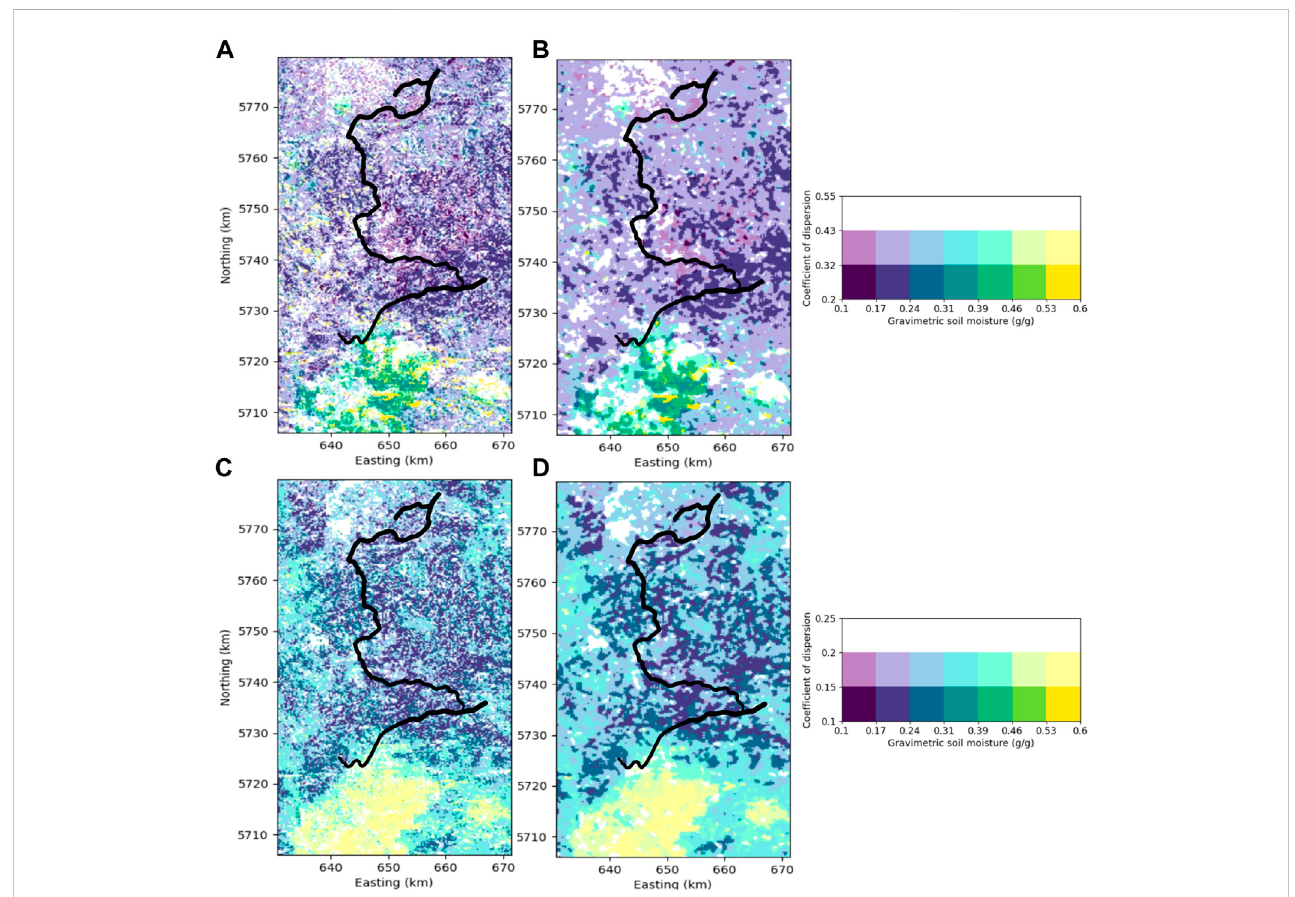
FIGURE 12 Soil moisture map with uncertainty quanti fi cation from quantile random forest (A) . Transparency is used with the colormap to represent the uncertainty information. (B) shows thedata from (A) after the application of mildspatial smoothing to remove noisy pixels and enhance uncertainty patterns visualization. Soil moisture map with uncertainty quanti fi cation from Monte Carlo approach with 1,000 iterations (C) and after application of a mild spatial smoothing (D)